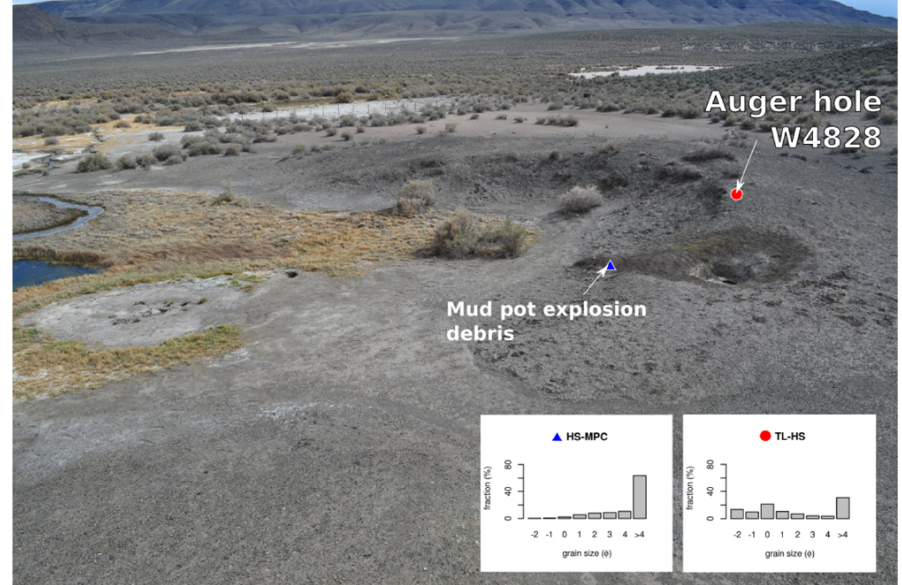
Figure 11. TL sample W4828 was collected from an auger hole in the berm southwest of the high- temperature area. The grain size chart for sample TL-HS (red dot) collected at the TL sample depth. The grain size chart HS-MPC (blue triangle) is for debris ejected from the mud pot between March and May 2014. Note the elevated berm surrounding the SW portion of the high-temperature area, up to 1.5 m in